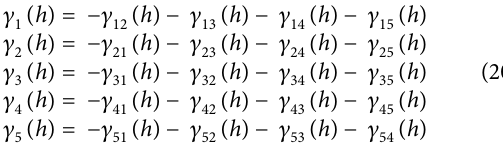
Frontiers in Earth Science |